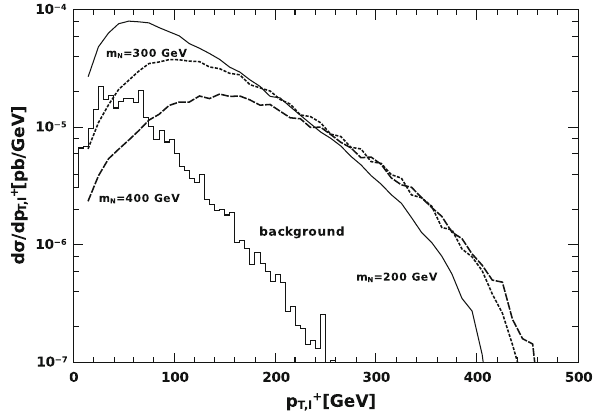
Fig. 3 Differential cross section of signal and background in function of transverse momentum p T , l + . The cut in missing E T is